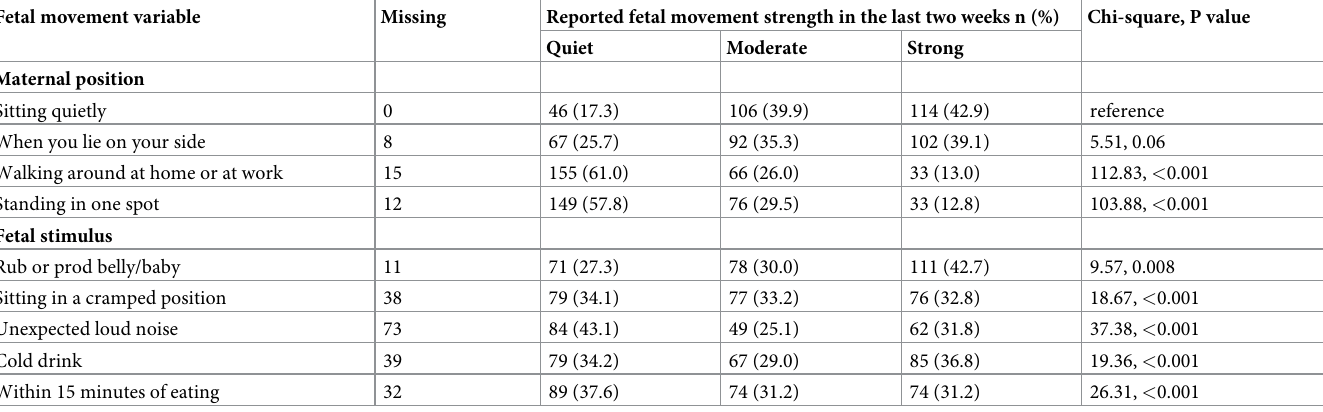
Table 5. Perceived strength of fetal movements in relation to maternal position (N =